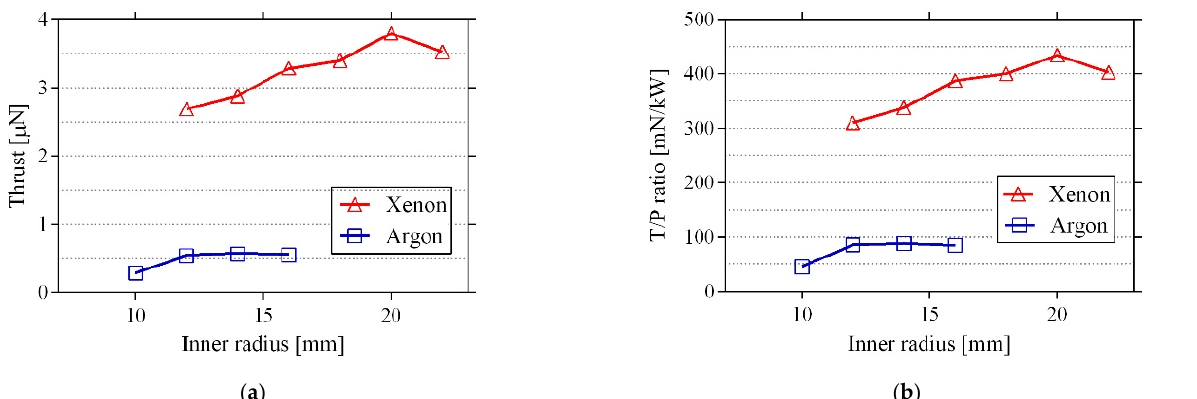
Figure 3. Influence of the cylindrical inner radius in the thruster’s performance at 20 kV: ( a ) variation of the output thrust T in ( µ N) for several radius (mm); ( b ) variation of the thrust-to-power ratio T / P in (mN/kW) for several radius (mm).